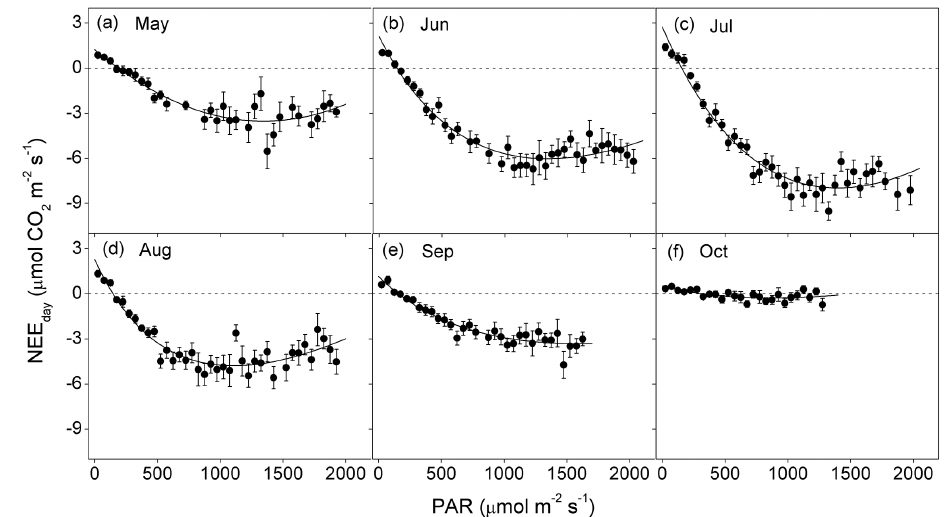
Figure 2. Daytime net ecosystem CO 2 exchange (NEE day ) as a function of incident photosynthetically active radiation (PAR) for each month from May to October in 2012. Half-hourly NEE day was bin-averaged into 50µmolphotonsm − 2 s − 1 PAR increments. Bars indicate standard errors. Light response curves were fit with Eq. (1). The dashed lines represent y = 0.